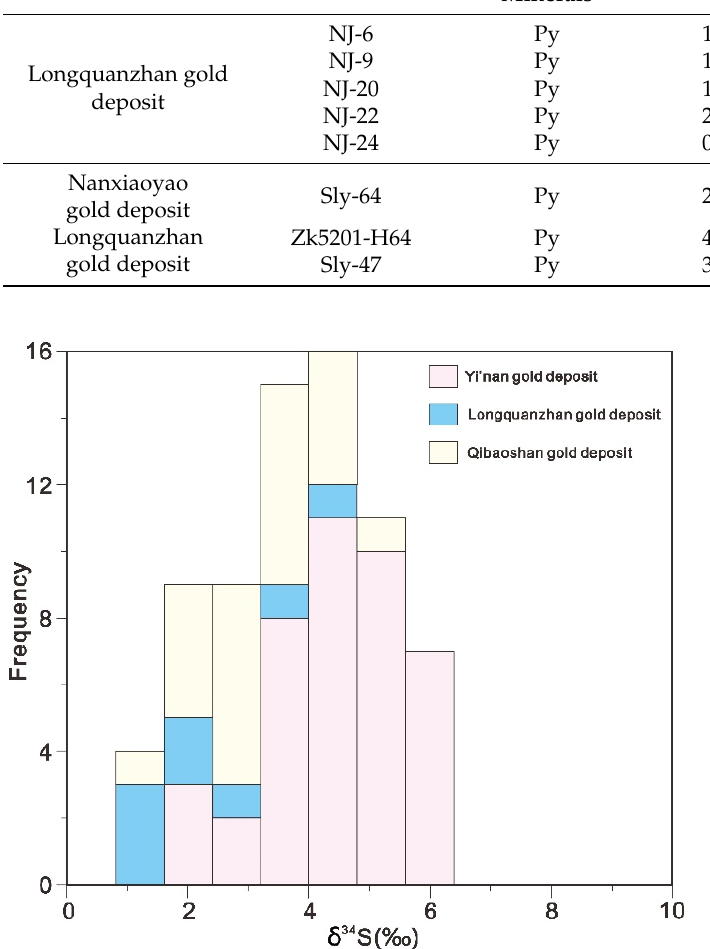
Figure 10. Histogram of sulfur isotopic compositions ( δ 34 S) of sulfides from the Longquanzhan gold deposit and the Luxi-Jiaodong gold ore system. The sulfur isotopic data for the Yi’nan and Qibaoshan gold deposits are from [4,48,49].